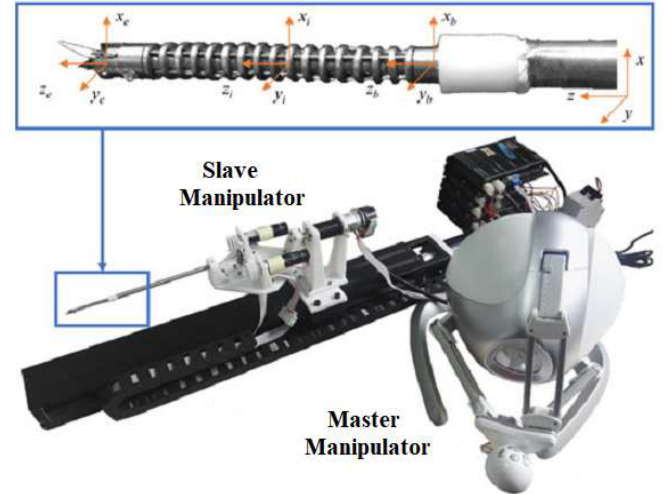
Figure 5. Surgical sinus robot manipulator.